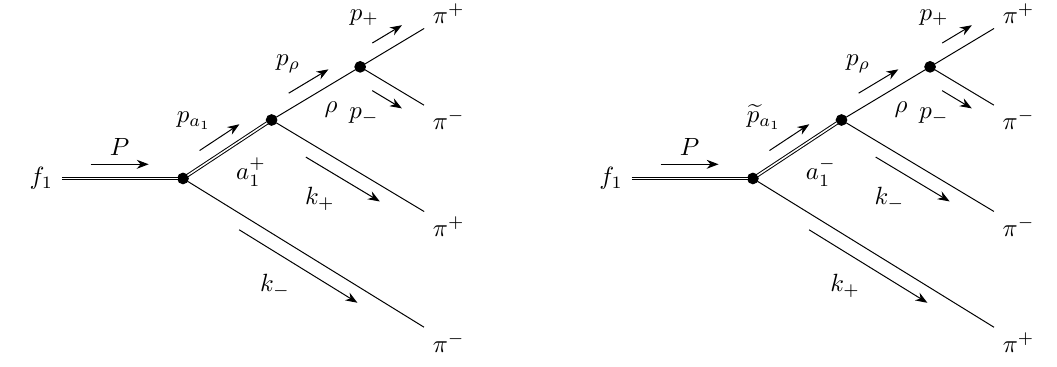
Figure 14 . Feynman diagrams for f 1 → π + π − π + π − via a 1 π . Since the two π + and π − are respectively indistinguishable, there exist eight diagrams in total, that is four diagrams with a + and four diagrams with a − ( right ), which are obtained by permuting the momenta 1